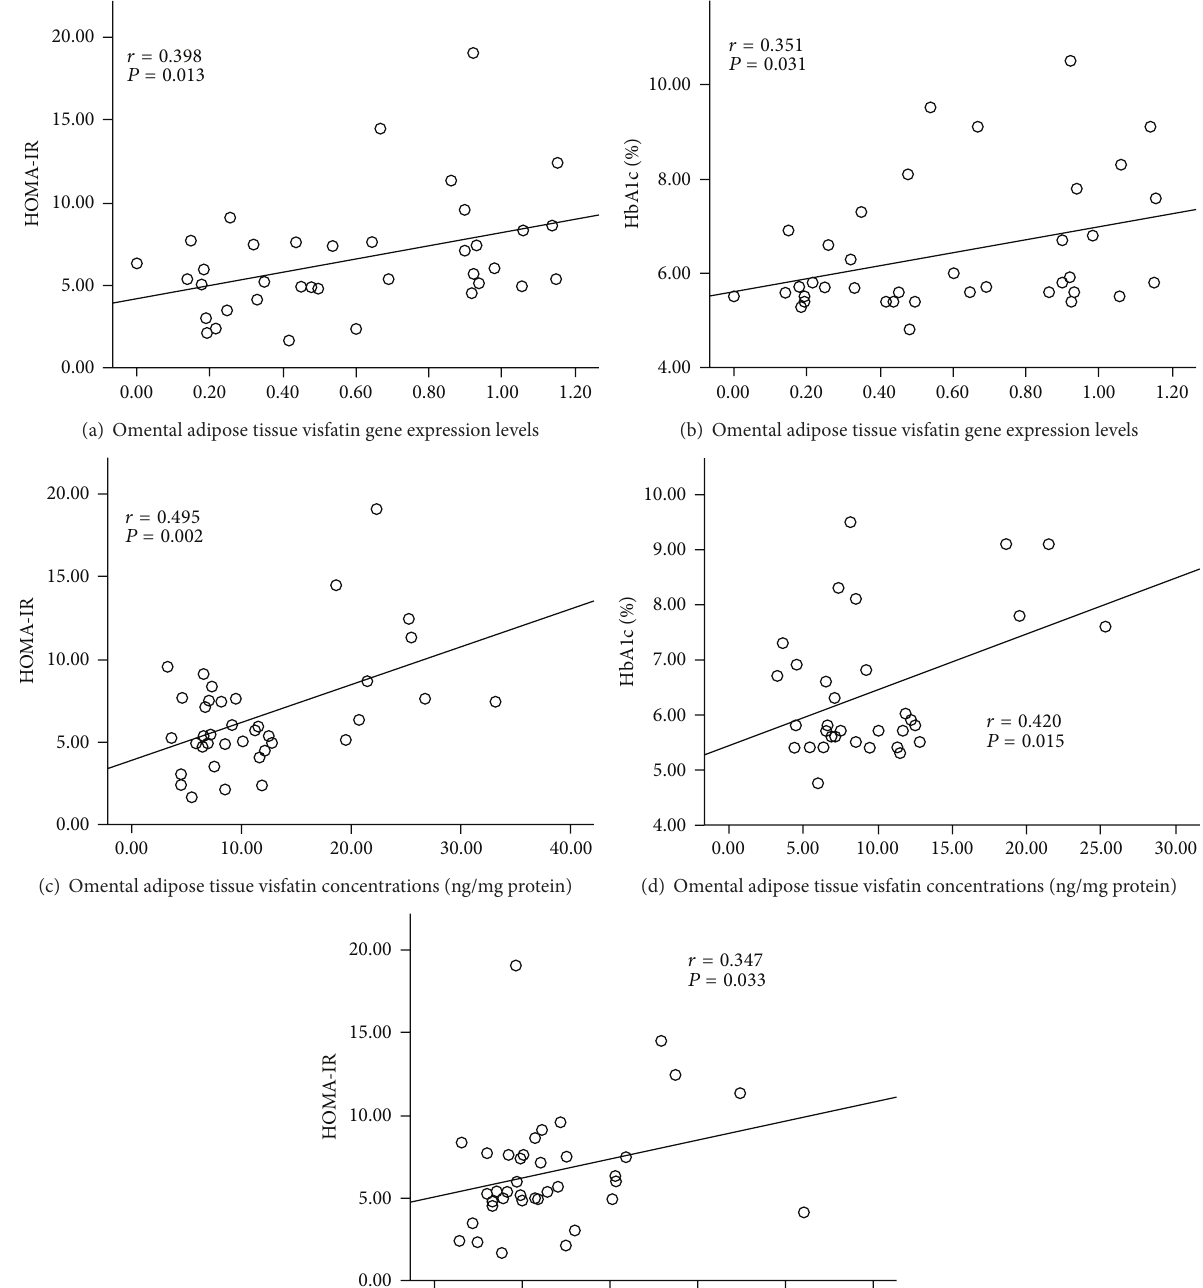
Figure 1: Correlation between tissue visfatin/Nampt gene or protein expression and blood insulin resistance biomarkers.